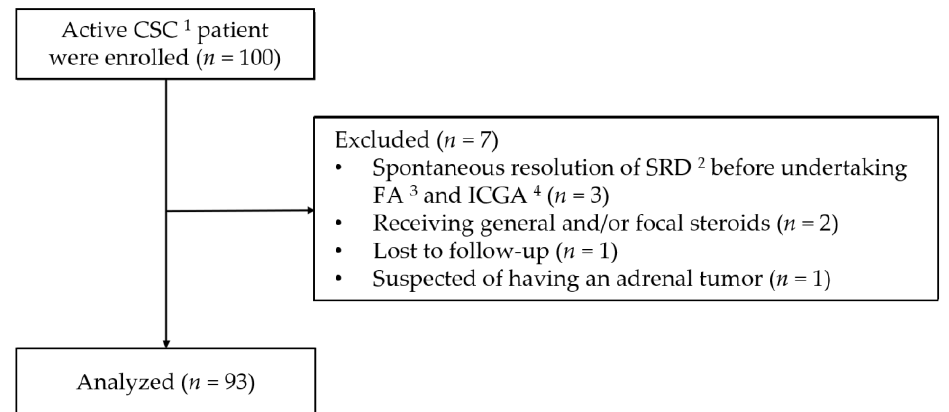
Figure 1. This study flow diagram. 1 central serous chorioretinopathy; 2 serous retinal detachment; 3 fluorescein angiography; 4 indocyanine green angiography. The mean blood concentrations of aldosterone, cortisol, ACTH, and 5-HT were 155.0 ± 65.9 pg/mL, 9.4 ± 3.3 µg/dL, 24.1 ± 9.9 pg/mL, and 94.5 ± 38.5 ng/mL respectively and